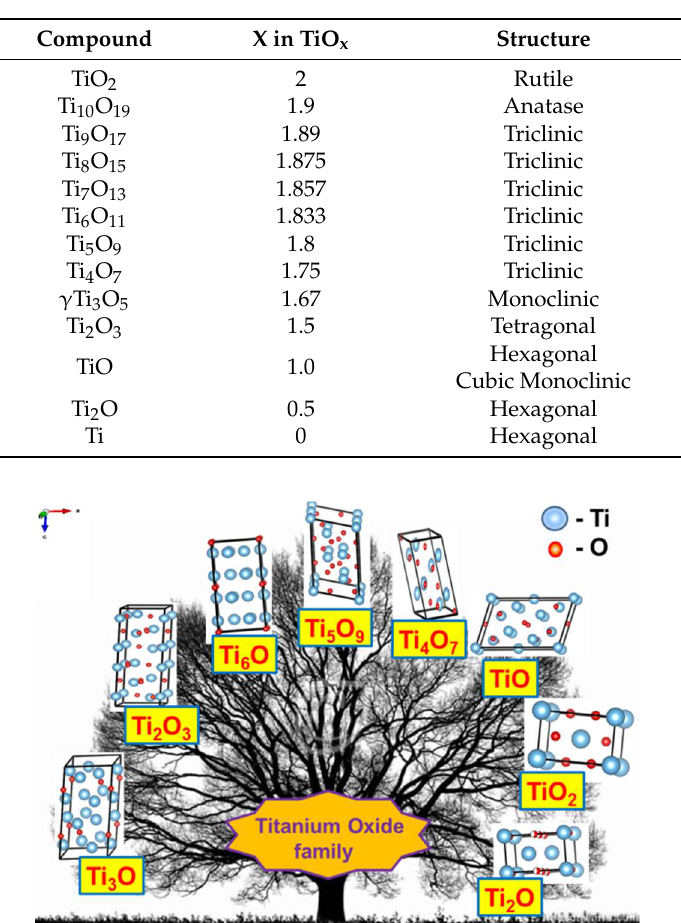
Table 3. Variation of the crystal structure with O/Ti stoichiometry.